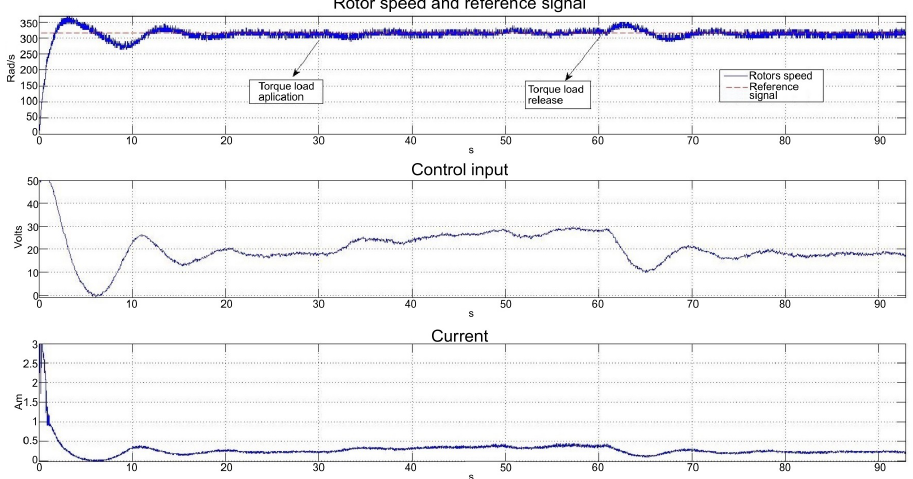
Figure 25. Responses to an unknown load